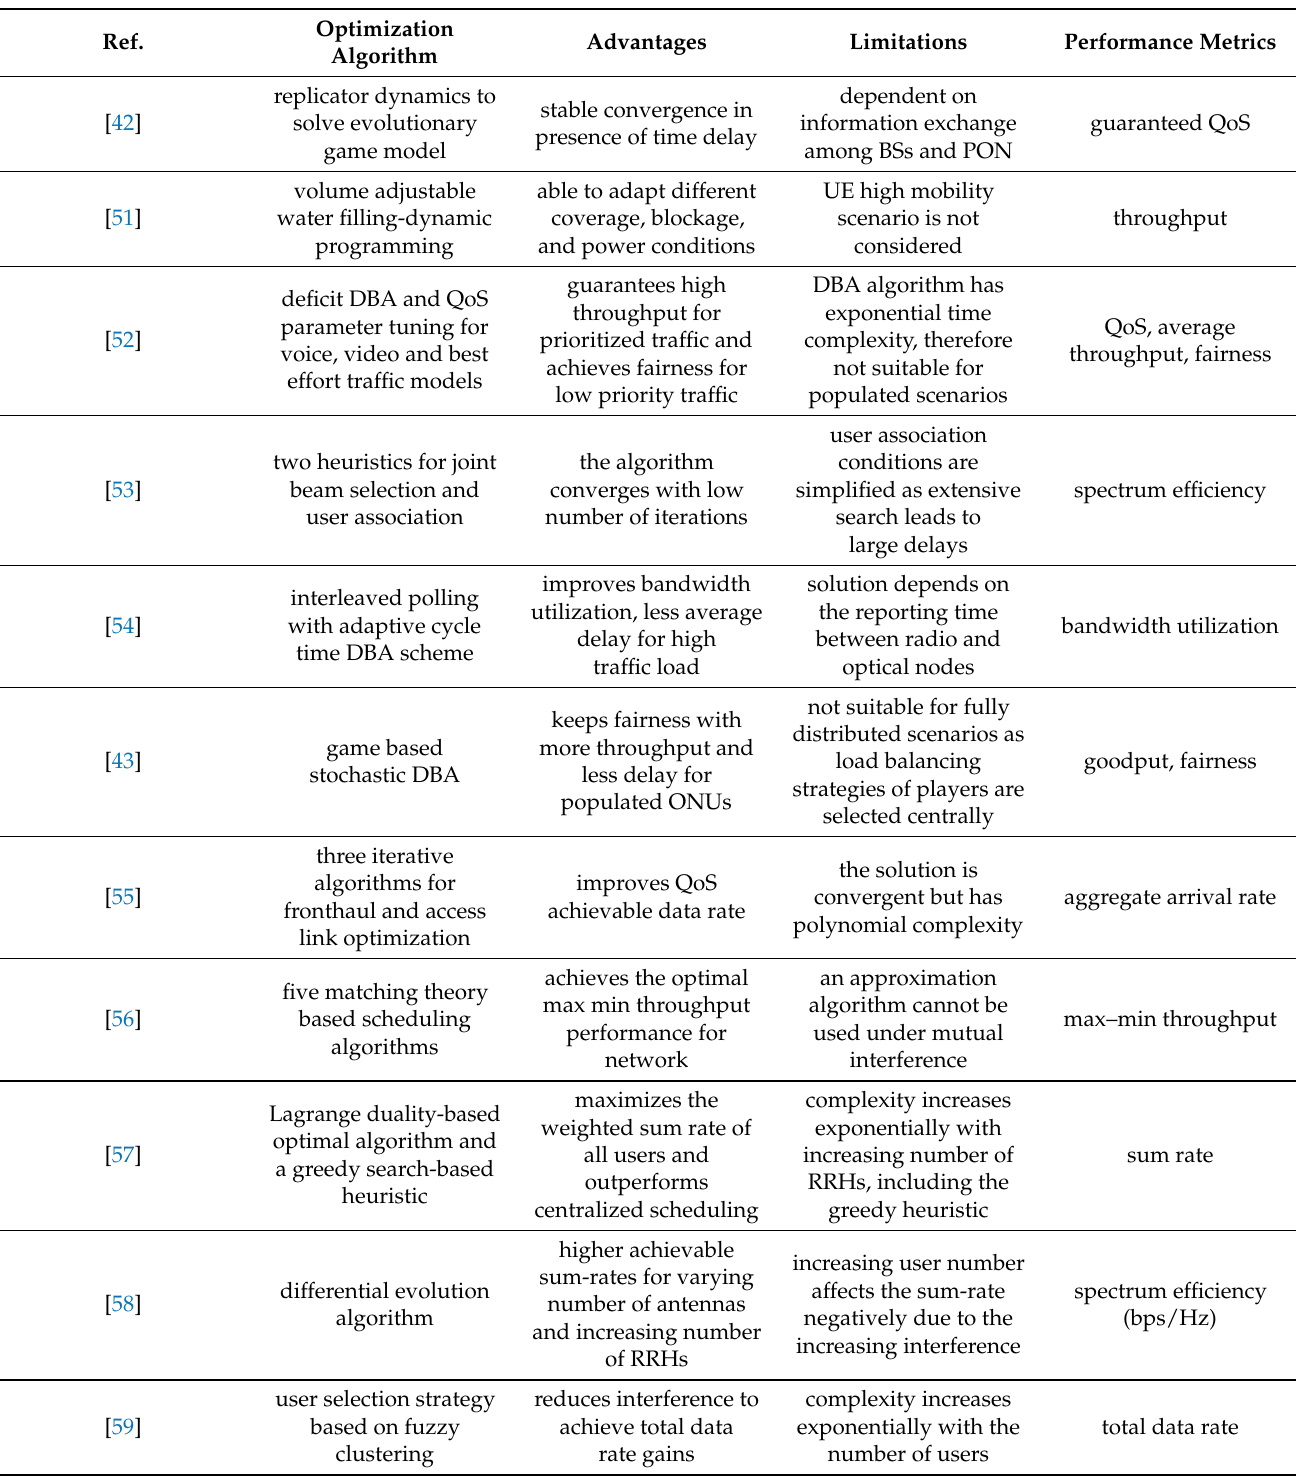
Table 3. Analysis of resource allocation papers with throughput maximization objective.